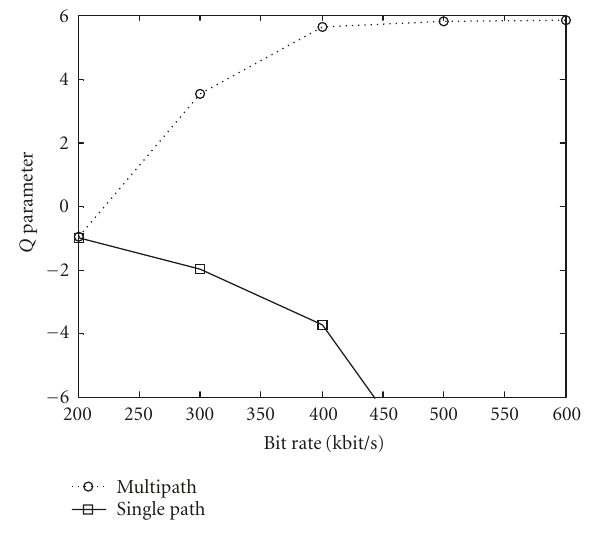
Figure 16: Objective parameter Q